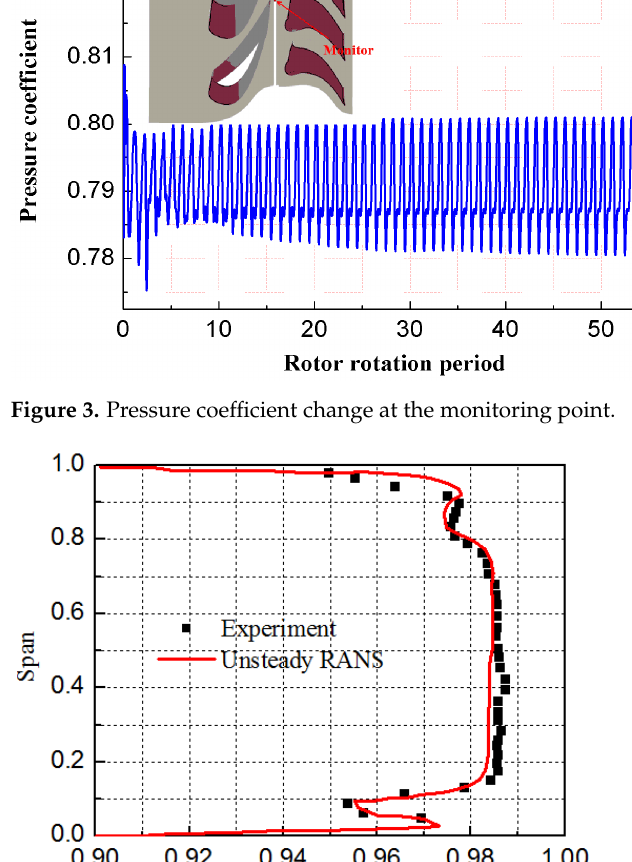
Figure 4. Total pressure coefficient at stator outlet.